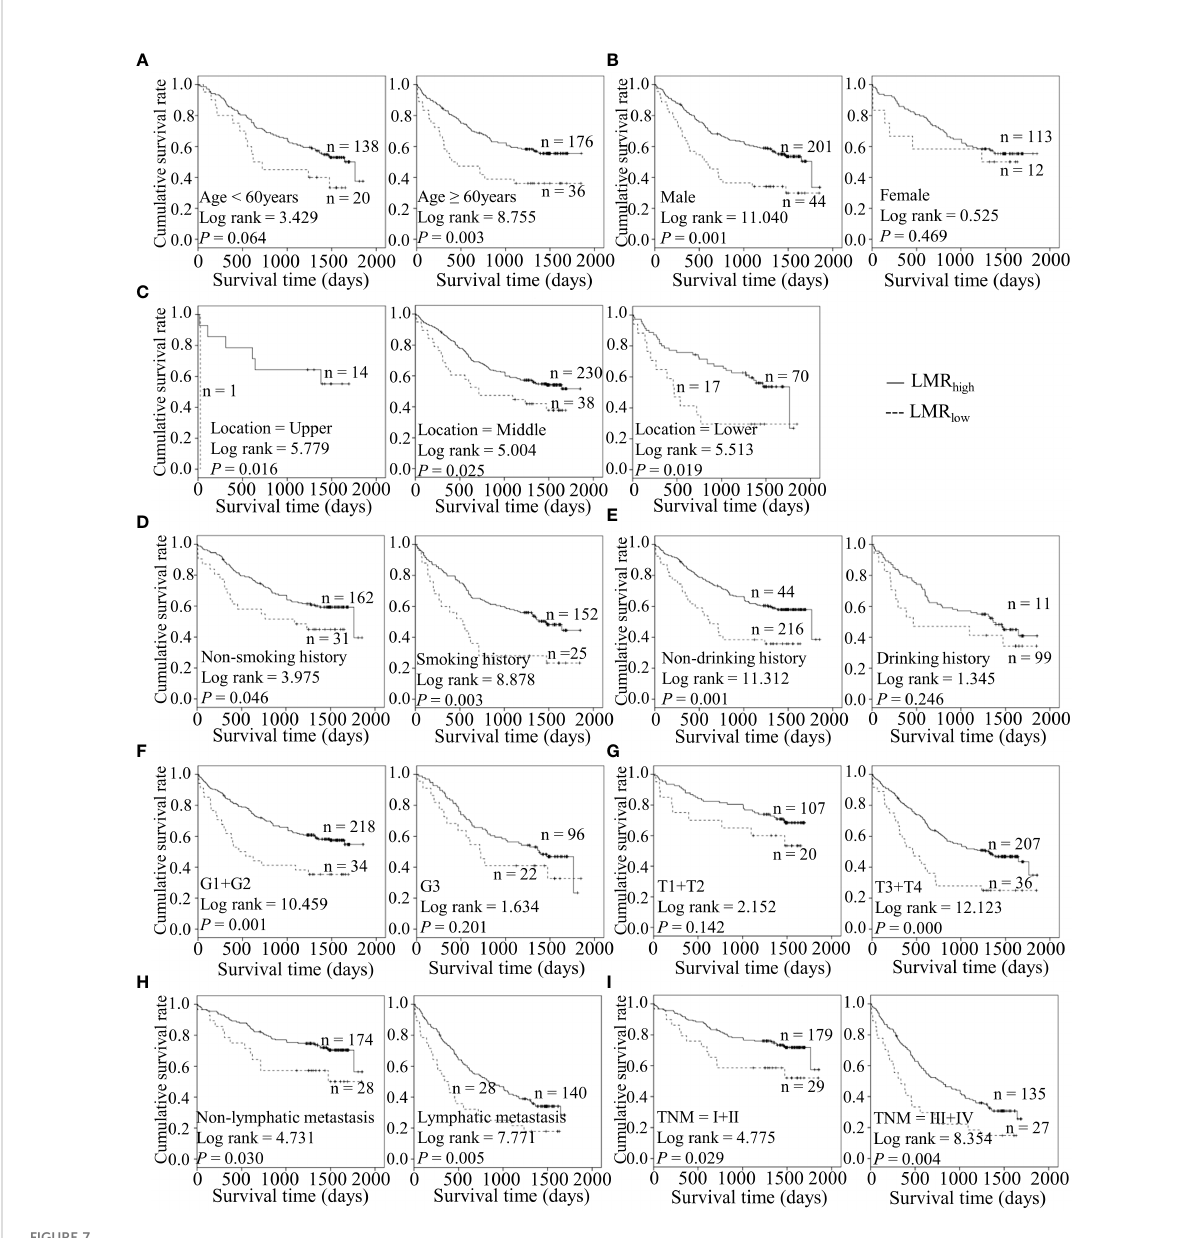
FIGURE 7 Predicating role of preoperative LMR level for the OS of ESCC patients. (A – I) Kaplan-Meier survival curves of ESCC patients with different LMR levels combined with diverse features like age (A) , gender (B) , tumor location (C) , smoking history (D) , drinking history (E) , tumor grade (F) , T stage (G) , lymph node metastasis (H) and TNM staging (I)